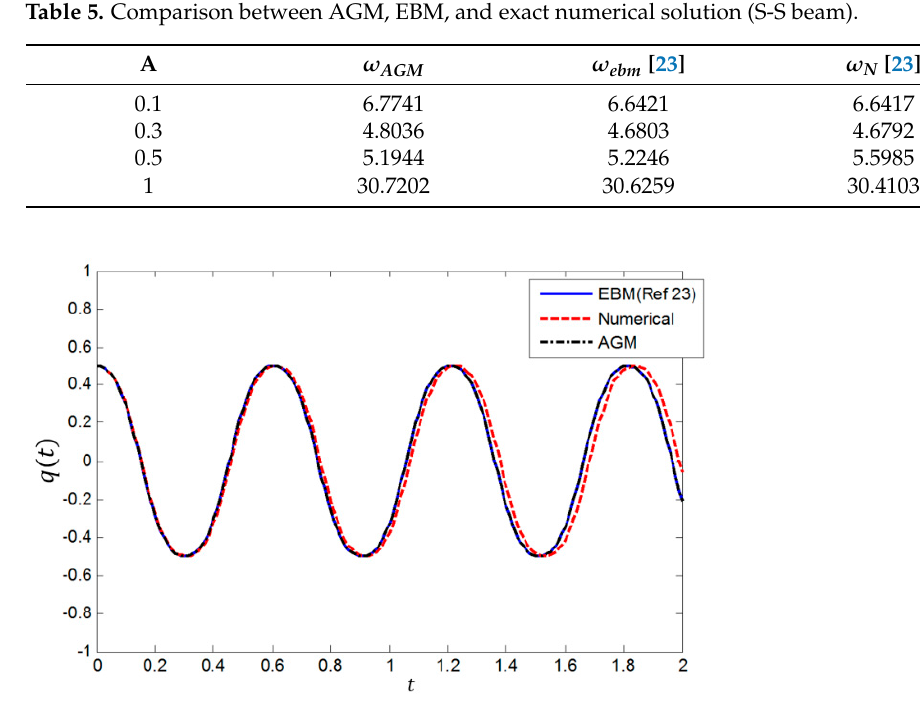
(cid:2889)(cid:2893)